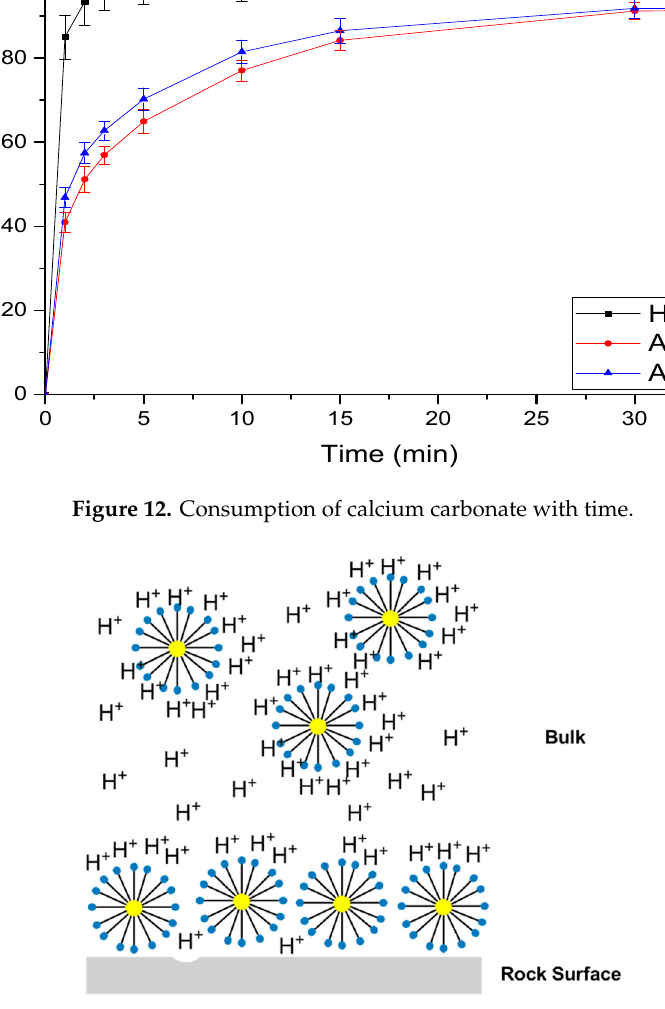
Figure 13. Representation of the acid oil-in-water nanoemulsion.